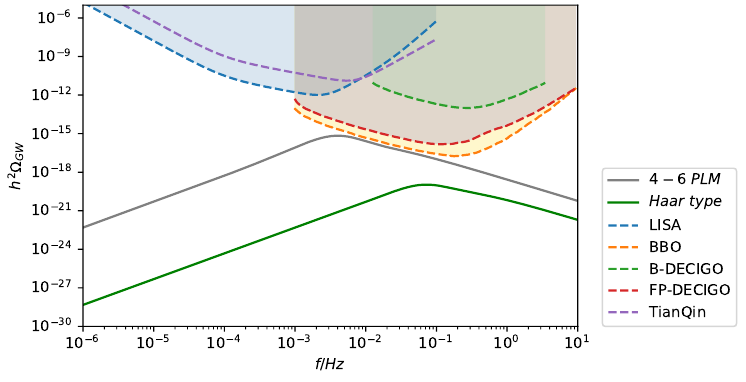
Figure 4 . GW spectra predicted from different models for N = 4 under an extreme scenario that the secluded dark gluon plasma to highly dominate over the SM plasma (i.e. ζ = 0 ). The critical temperature has been set as T = 270 MeV. For more details, see the text. c